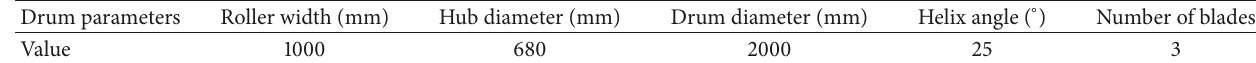
Table 3: Parameters of interest for drum-type